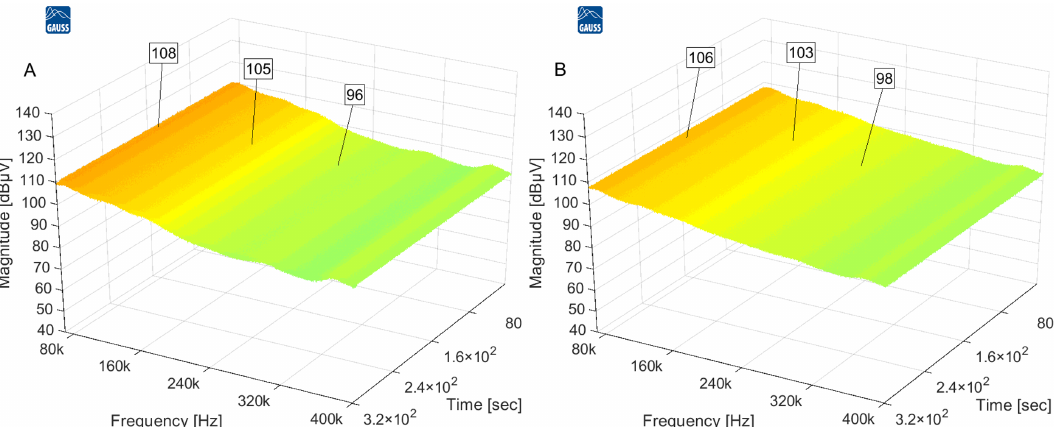
Figure 6. Experimental 3D spectrograms of interference measured using AV detector, caused by one DC/DC converter with RanM ( A ), and two DC/DC converters with RanM ( B ).